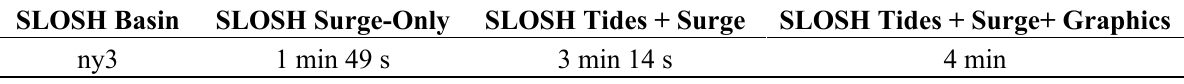
Table 3. AutoSurge runtime performance for the SLOSH ny3 basin.